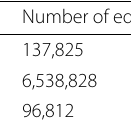
Table 5 Number of edges and nodes of Litecoin’s MTG graph in its first 3 months